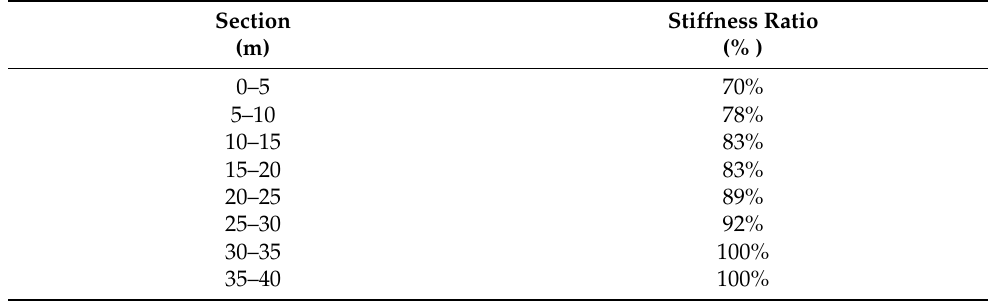
Table 5. The ratio between the calculated stiffness obtained in correspondence to the Step fun and the elastic stiffness (Step el,lim